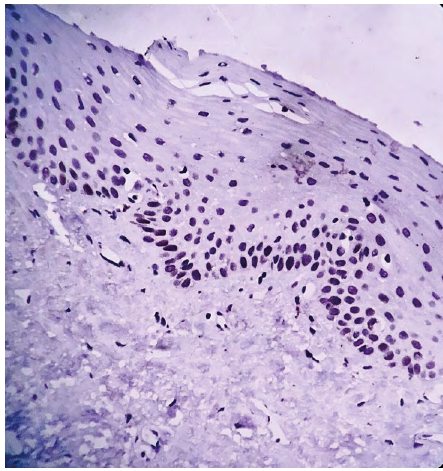
Figure 2. Positive expression of p53 in the basal and parabasal layers of resected surgical margins.